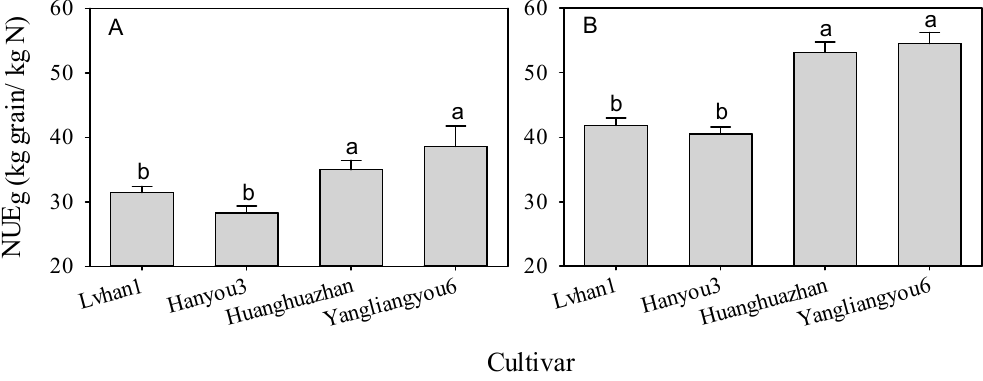
Figure 5. Comparison of nitrogen use efficiency for grain production (NUEg) among tested cultivars in 2012 ( A ) and 2013 ( B ). Lvhan1 (inbred) and Hanyou3 (hybrid) are typical upland rice cultivars. Huanghuazhan (inbred) and Yangliangyou6 (hybrid) are well-known lowland rice cultivars. Error bars represent SE. Different letters in each year means the significant differences at 0.05 level.